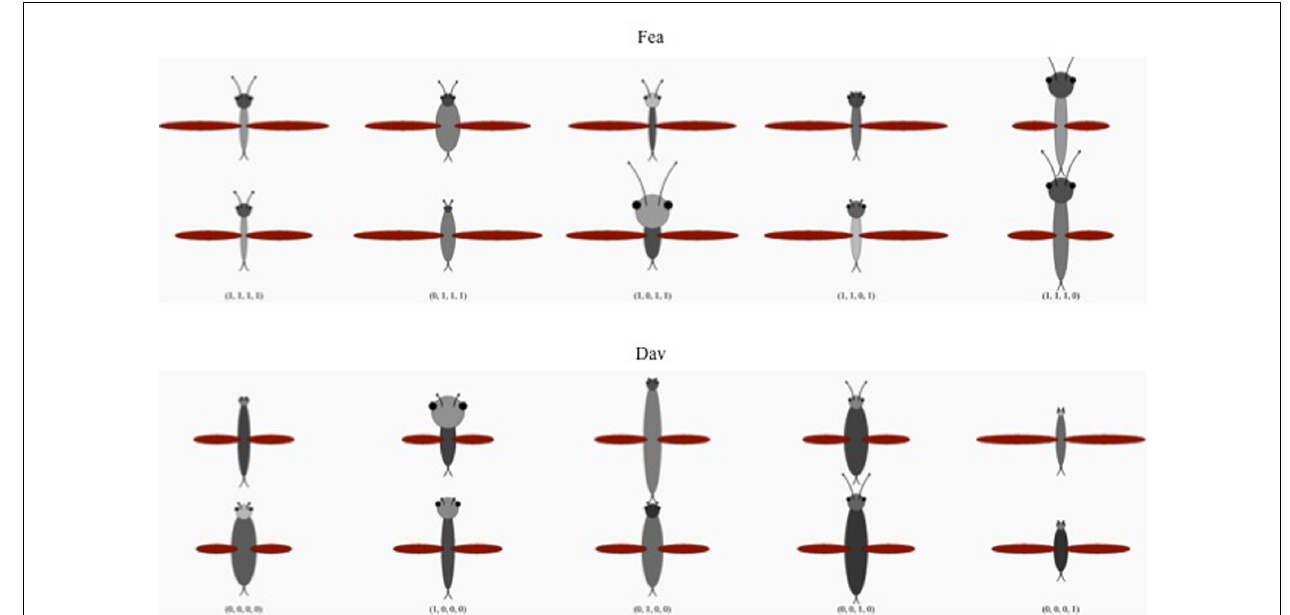
in the relative width of the bugs’ heads and bodies (r1). Examples of a prototype or an exemplar class differ from one another in their metric properties (e.g., head width) but share categorical relations (e.g., whether the head is wider or narrower than the body).The figure shows two randomly selected examples of each prototype or exemplar class, out of an open-ended set of such examples (with each example differing from the others in its class in terms of its precise metric properties). See text for details.